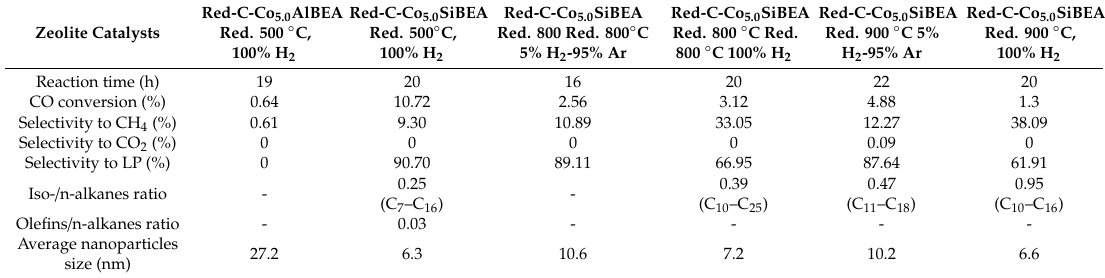
Table 5. The catalytic activity and selectivity, the isoalkanes and olefins to n-alkanes ratio and nanoparticles size for Red-C-Co 5.0 AlBEA and Red-C-Co 5.0 SiBEA. Zeolite